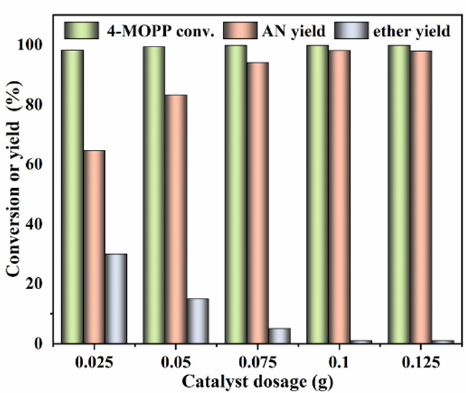
Figure 6. The influence of different alcohols; Reaction conditions: 1 mmol 4-MOPP, 10 mL alcohols, 0.1 g PhP-Hf (1:1.5) catalyst, 220 °C for 2 h.